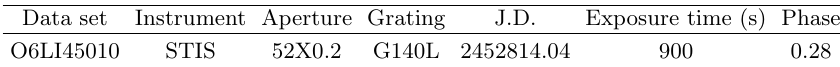
Table 4. Journal of HST observations of AN